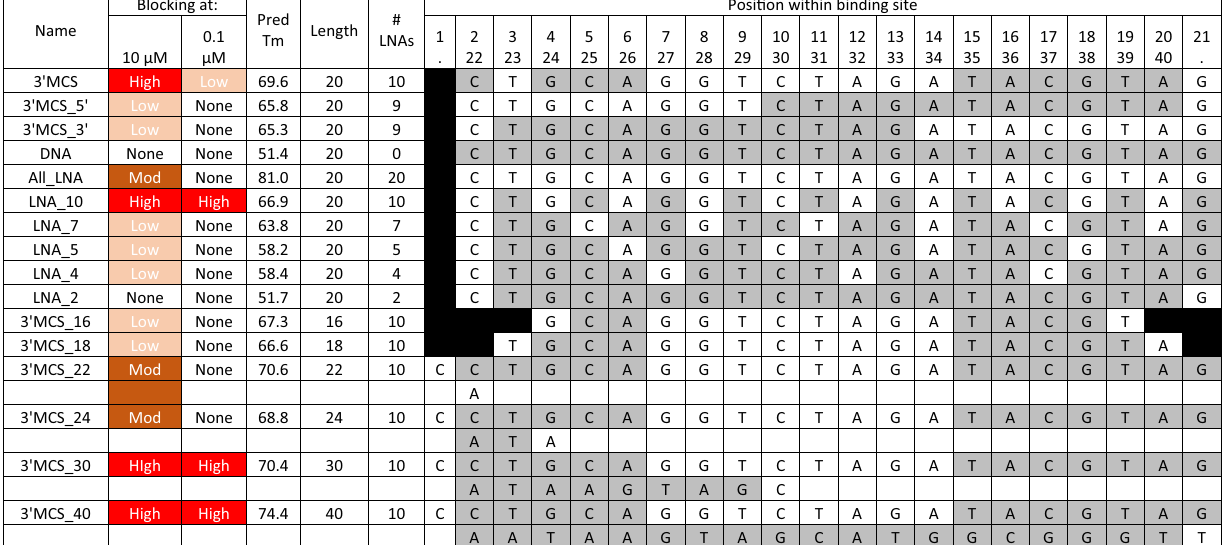
position (Table S1). Individual LNAs were used to block amplification at 1 µM, with their effectiveness measured using quantitative capillary electrophoresis relative to samples with no LNA added (Fig. S1, Table 2). Effectiveness varied significantly among oligonucleotides. In most cases (10 of 12 tested), blockers with LNAs starting in the second/even positions were more effective than the same blockers with LNAs in the first/odd positions. Nearly